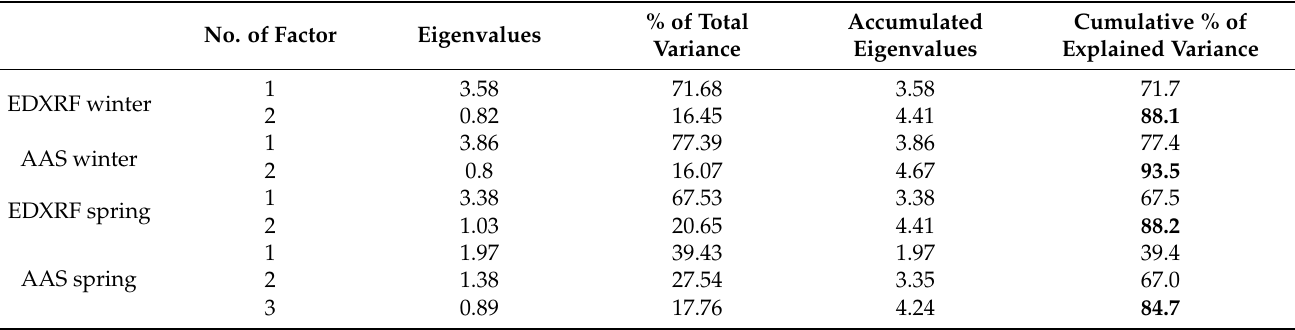
Table 9. Eigenvalues of the correlation